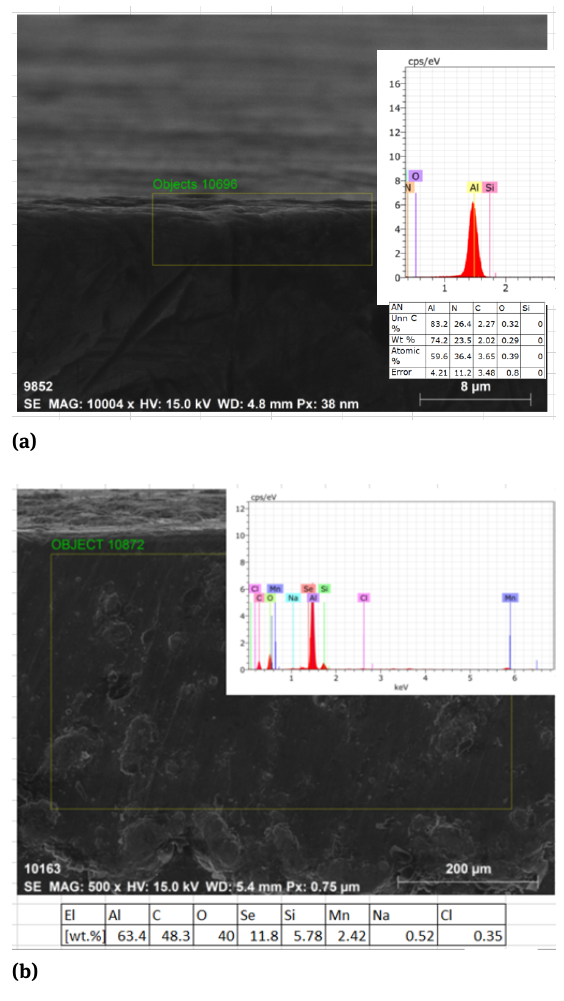
Figure 9: a) FESEM of the cross-section of the non-coated Al 6061 sample; b) FESEM of the cross-section of the coated Al 6061 sam- ple.